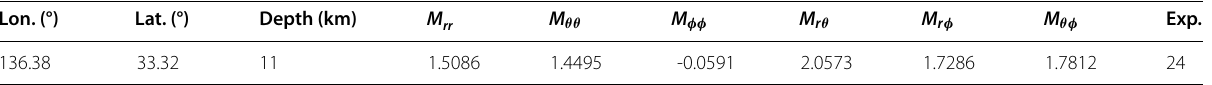
Table 1 Detailed parameter information for the optimal moment tensor of the 2016 SE offshore Mie earthquake. The moment tensor is described in the GCMT format Lon. (°)